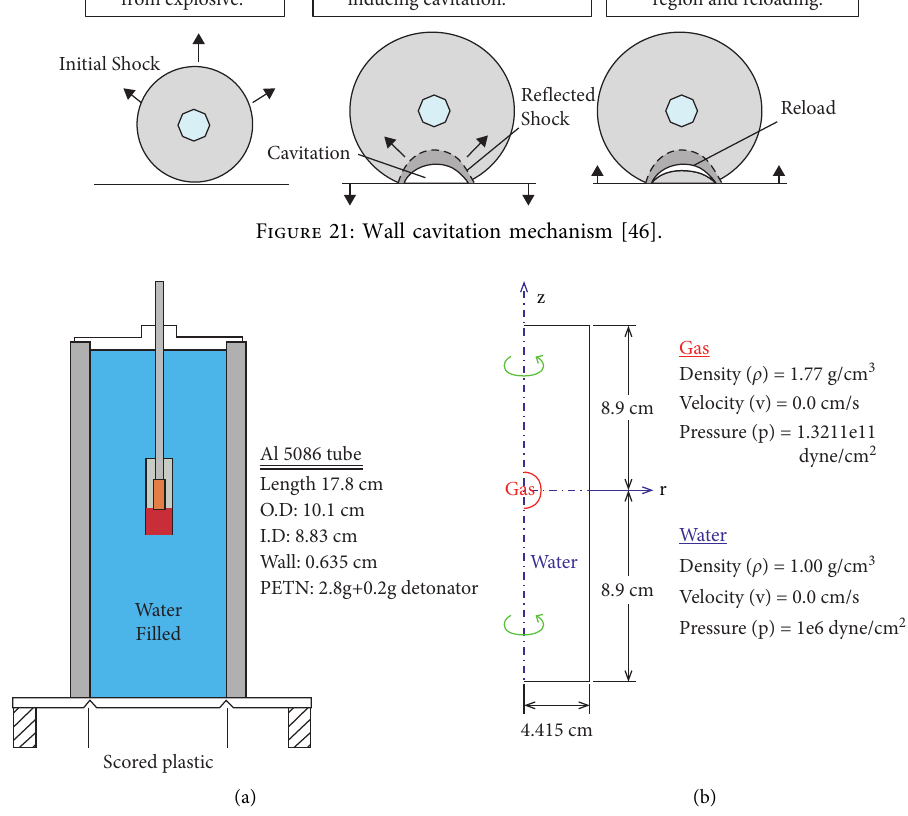
Figure 22: Experimental arrangement and its modeling. (a) Experimental arrangements. (b) Initial